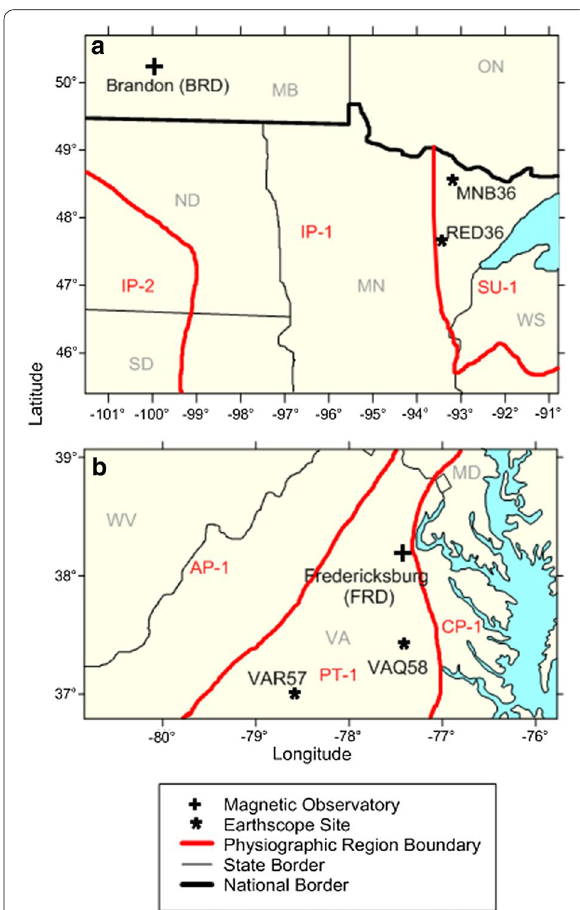
Fig. 1 Maps showing the locations of the magnetic observatories (available through the INTERMAGNET program) and the EarthScope USArray survey sites referenced to physiographic zones in red [derived from Fernberg (2012)]. a The NRC Brandon (BRD) magnetic observatory in Manitoba and the EarthScope sites MNB36 and RED36 in northern Minnesota. Both sites fall within the SU-1 physiographic zone. b The USGS Fredericksburg (FRD) magnetic observatory in Virginia and the EarthScope sites VAR57 and VAQ58 in southern